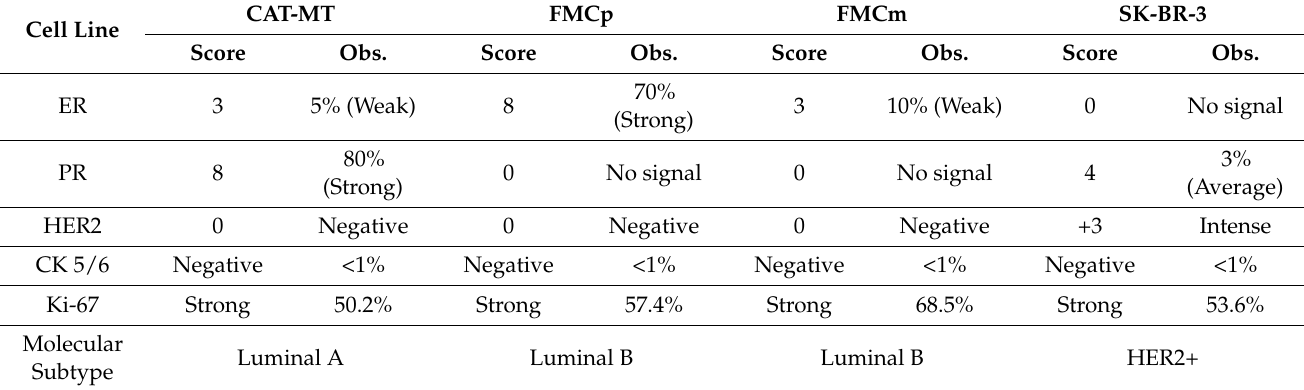
Table 1. Molecular subtypes of feline mammary carcinoma cell lines. The feline cell lines (CAT-MT, FMCp, and FMCm) and the human breast cancer cell line SK-BR-3 were evaluated by immunocytochemistry for estrogen receptor (ER), progesterone receptor (PR), epidermal growth factor receptor type 2 (HER2), cytokeratin 5/6 (CK 5/6), and Ki-67 molecular markers. The scoring criteria are presented in Supplementary Tables